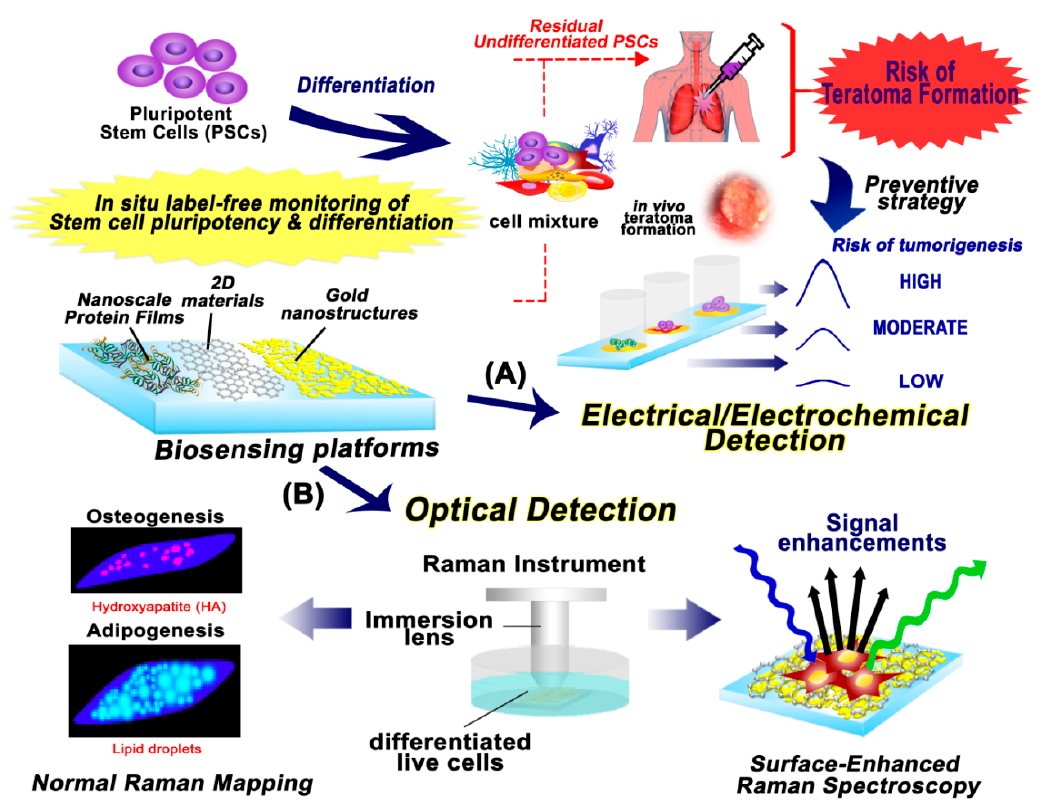
Figure 1. Schematic diagram of nanobiosensing platform for real-time and non-invasive monitoring of stem cell pluripotency and differentiation. This illustration represents the potential of biosensing platforms for: ( A ) electrical/electrochemical detection of stem cell pluripotency and differentiation through electrochemical measurement; and ( B ) optical detection to monitor the successful differentiation of stem cells through Raman spectroscopy.